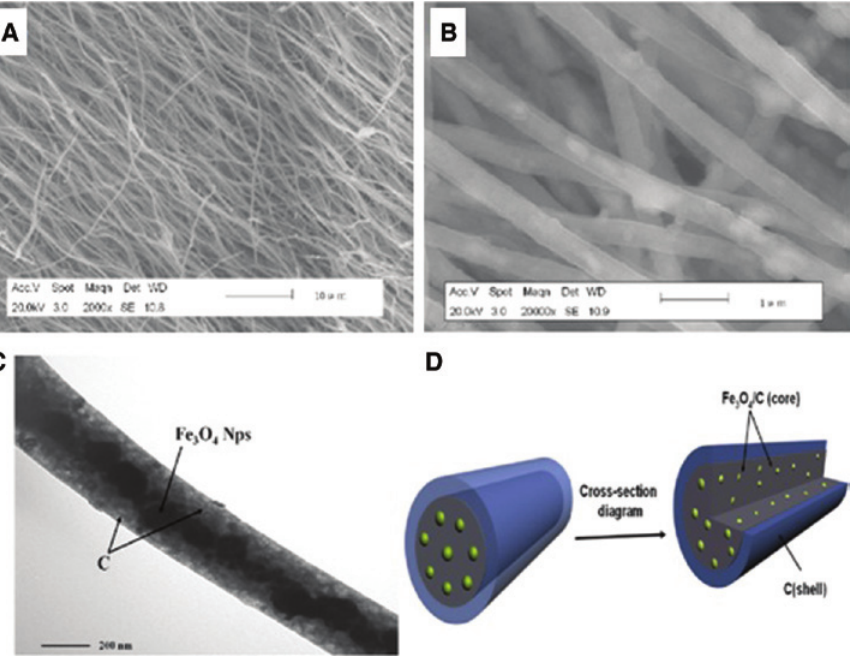
O ]/@C coaxial nanocables (C) TEM image, (D) structural schematic diagram of 3 4